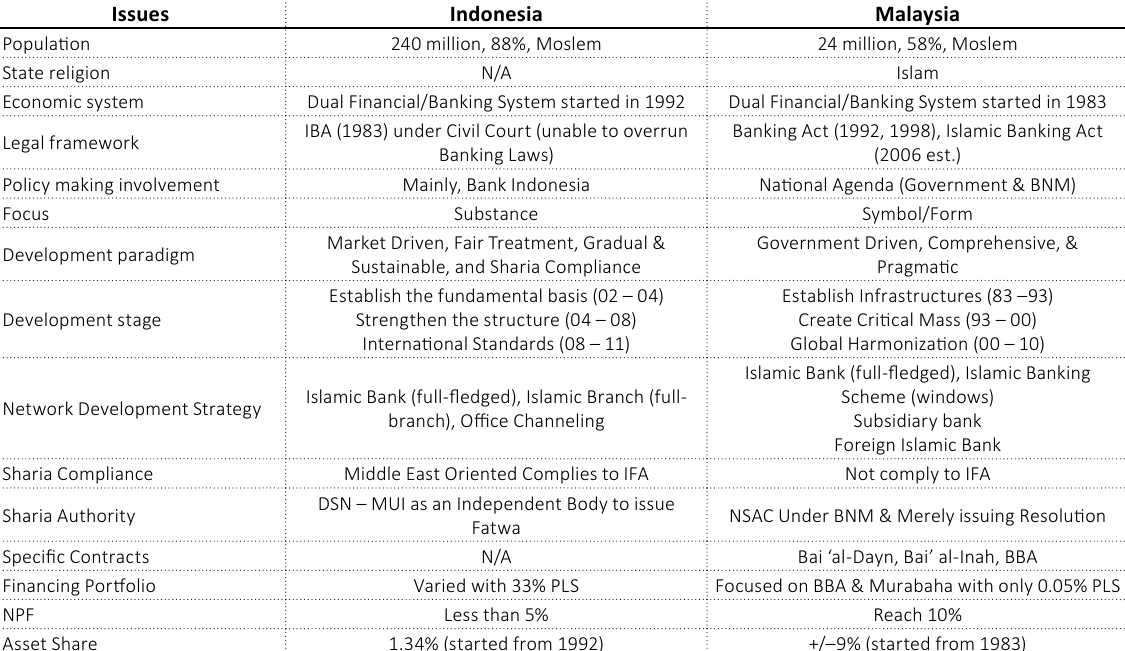
Table 1. The characteristics of Indonesian and Malaysian Islamic